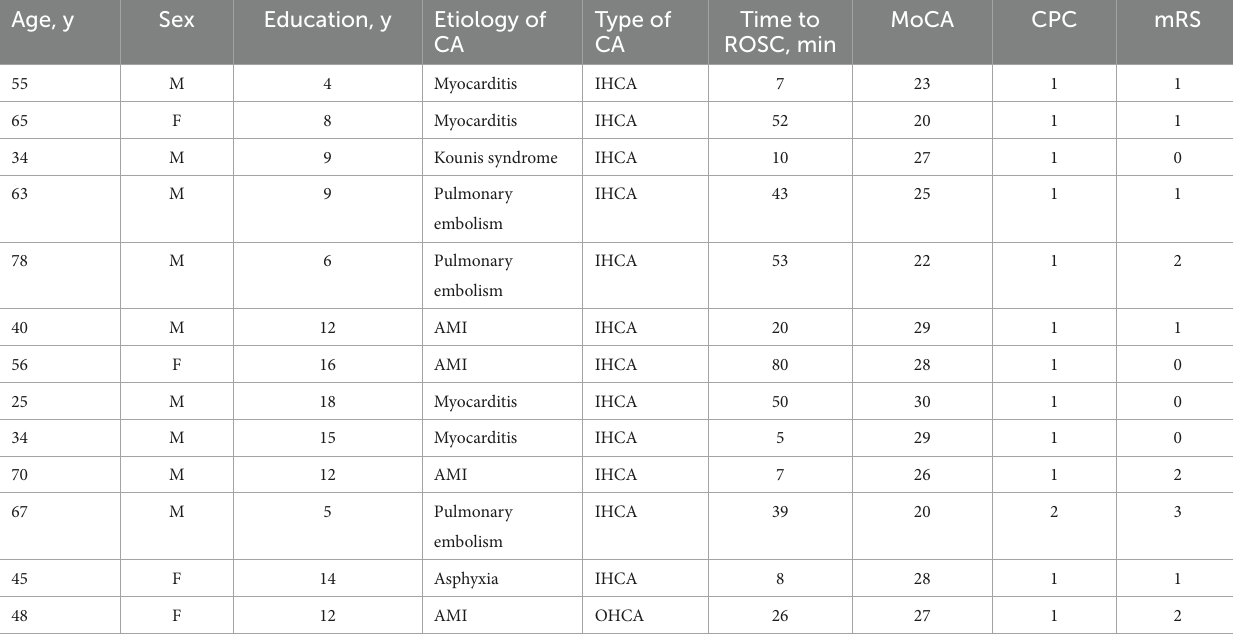
TABLE 1 Demographic and clinical characteristics of the patient group.